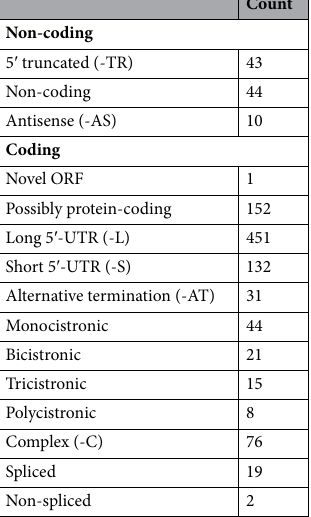
Table 2. Transcript isoform annotated in BoHV-1.